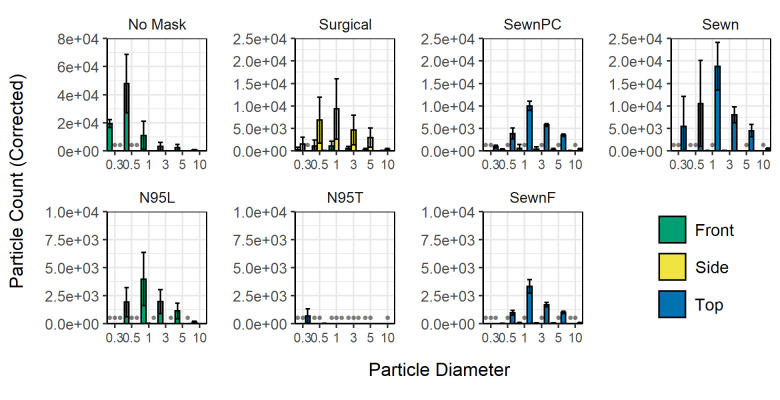
Background-corrected particle counts comparing facemask treatments within the enclosed box.Measurements shown for the six particle size bins are shaded and grouped by the measurement position (Front—Green, Left; Side—Yellow, Middle; Top—Blue, Right). Row 1 includes No Mask, Sewn, SewnF, SewnPC. Row 2 includes more advanced and commercially available facemask treatments (Surgical, N95L, and N95T masks). Gray bullet points at the baseline indicate negative corrected counts. Error bars indicate the sample standard deviation for particle counts in each of the respective particle size bins from three independent measurements. A 2-factor MANOVA and subsequent 2-factor ANOVAs were performed in addition to Tukey's Honest Significant Difference tests; p-values, relevant parameters, and analysis are shown as interactive maps and graphs included in S2 File.